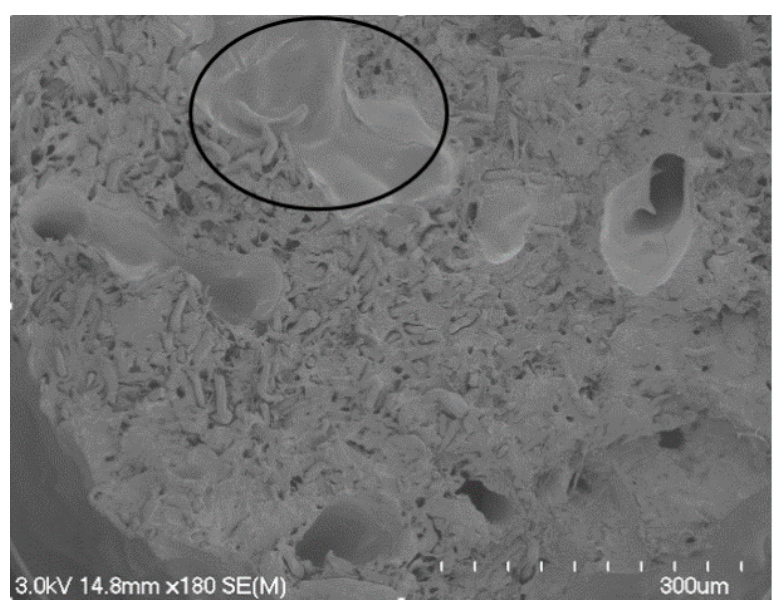
Figure 8. 20 wt % harakeke 1-mm strand cross-section.